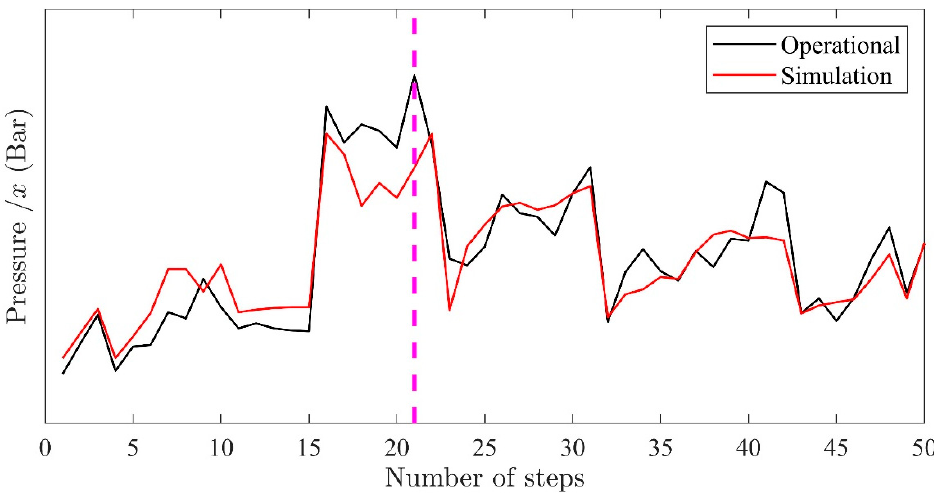
Figure 8. Matching operational and simulation pressure data to obtain the permeability field before and after the hydraulic stimulation process. The pink dotted line marks the occurrence of a micro- seismic event, which significantly changed reservoir injectivity.